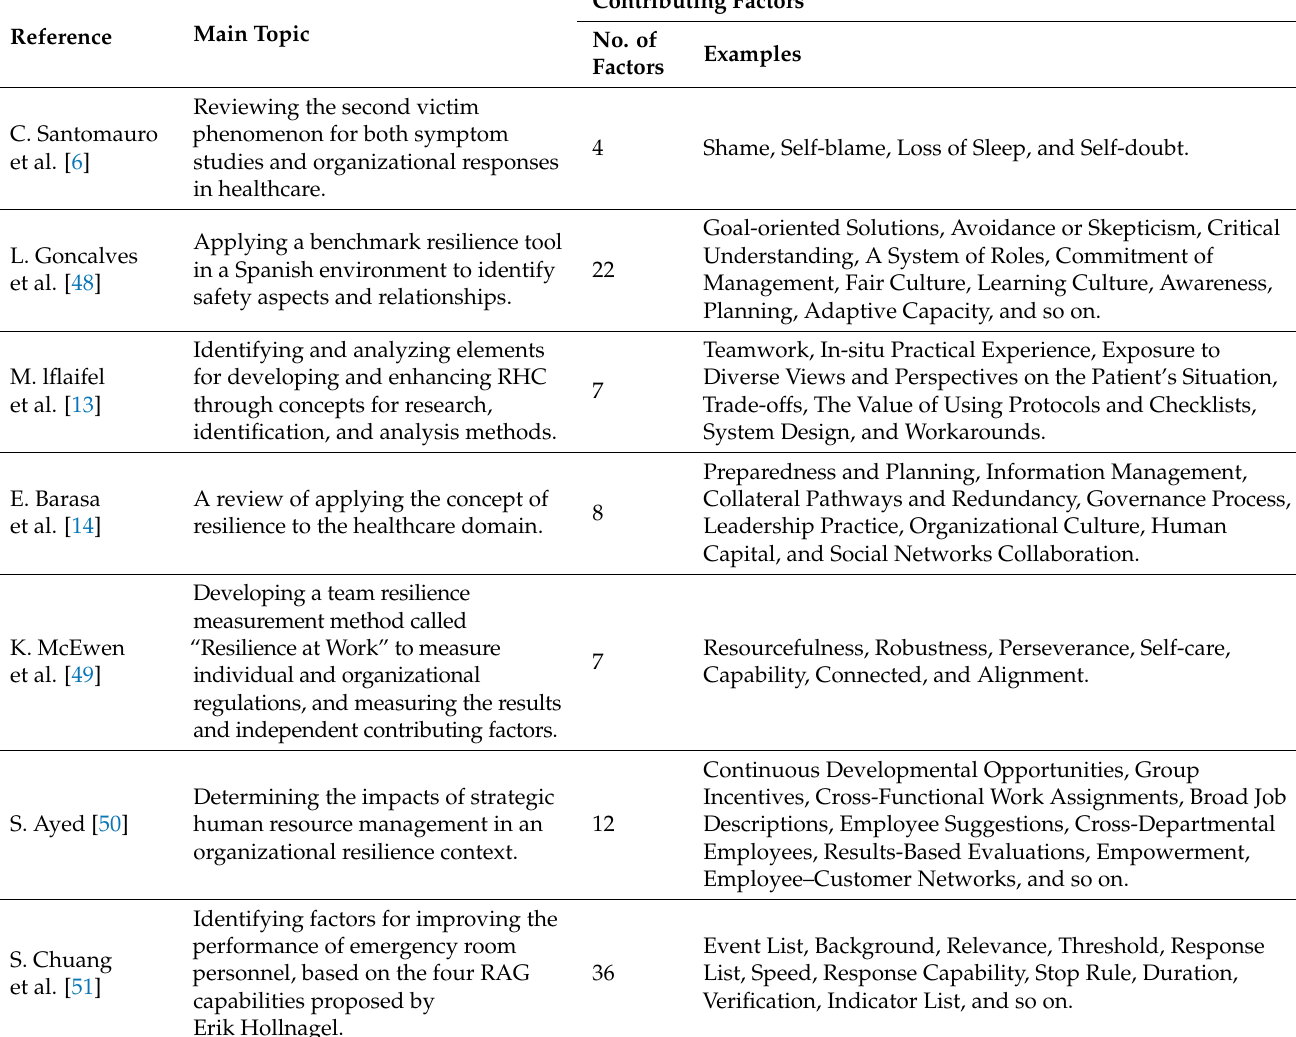
Table 4. Summary of identified contributing factors from the medical and healthcare